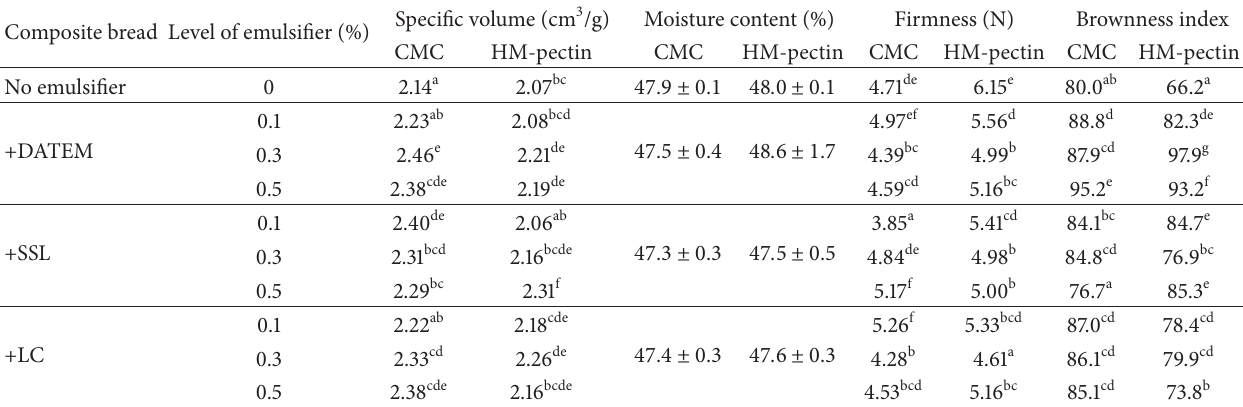
Table 3: Effect of type and concentration of hydrocolloids 1 and emulsifiers 2 on specific loaf volume, moisture content, firmness, and brownness index value in composite cassava-maize-wheat (CMW) breads. Specific volume (cm 3 /g) Moisture content (%) Firmness (N) Composite bread Level of emulsifier (%) CMC CMC